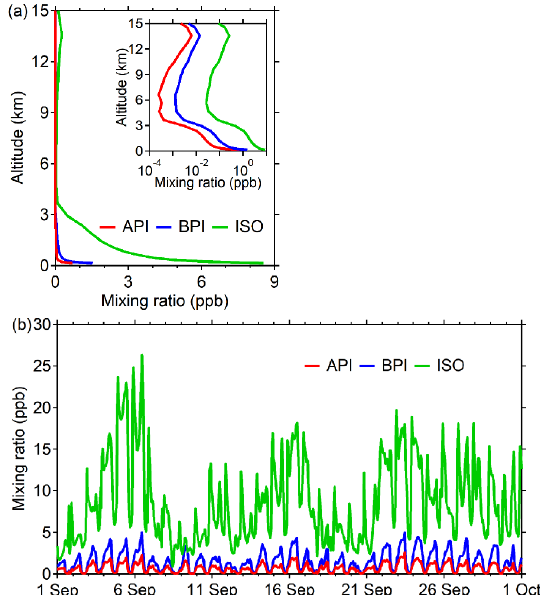
Figure A4. Simulated (a) vertical profiles and (b) time series of α -pinene (API), β -pinene (BPI), and isoprene (ISO) mixing ratios (STP) at the location of ATTO. The embedded figure in (a) is the same as the outer figure but on a log scale.